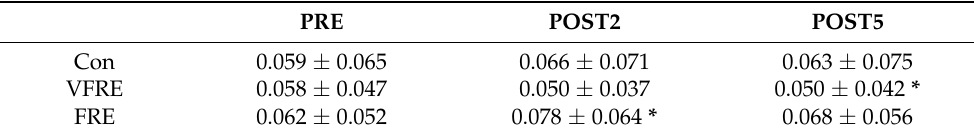
Table 4. The hip powe of DJ (W/BW); mean ± SD † .